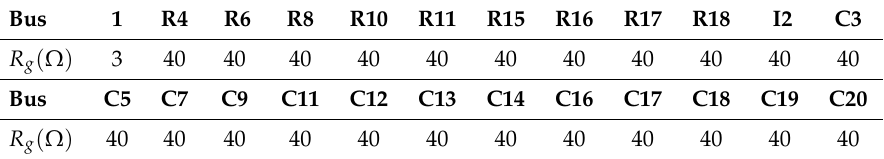
Table 3. Neutral ground